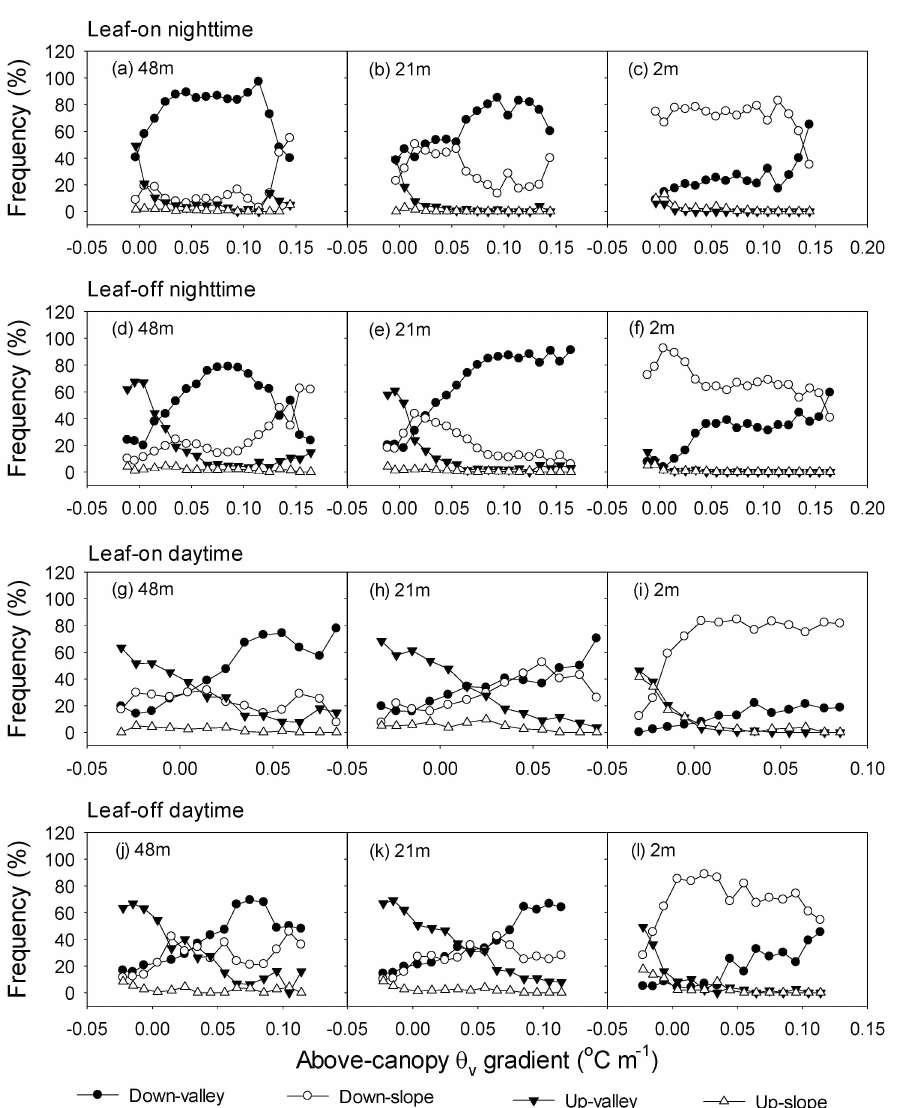
Figure 9. Changes of the relative frequency of mean wind direction sector at the 48 m, 21 m and 2 m with the gradient of above- canopy virtual potential air temperature (θ v ) in 2012. ( a ), ( b ), ( c ) are in the nighttime for 48 m, 21 m and 2 m in the leaf-on season, respectively, and ( d ), ( e ), ( f ) are in the nighttime for 48 m, 21 m and 2 m in the leaf-off season, correspondingly, ( g ), ( h ), ( i ) are in the daytime for 48 m, 21 m and 2 m in the leaf-on season, respectively, and ( j ), ( k ), ( l ) are in the daytime for 48 m, 21 m and 2 m in the leaf-off season,